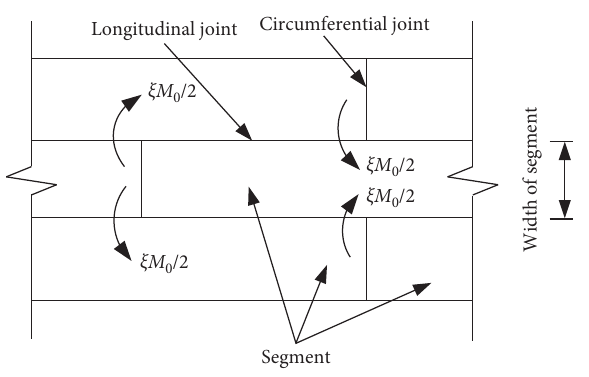
Figure 3: Transferring of bending moment between adjacent rings